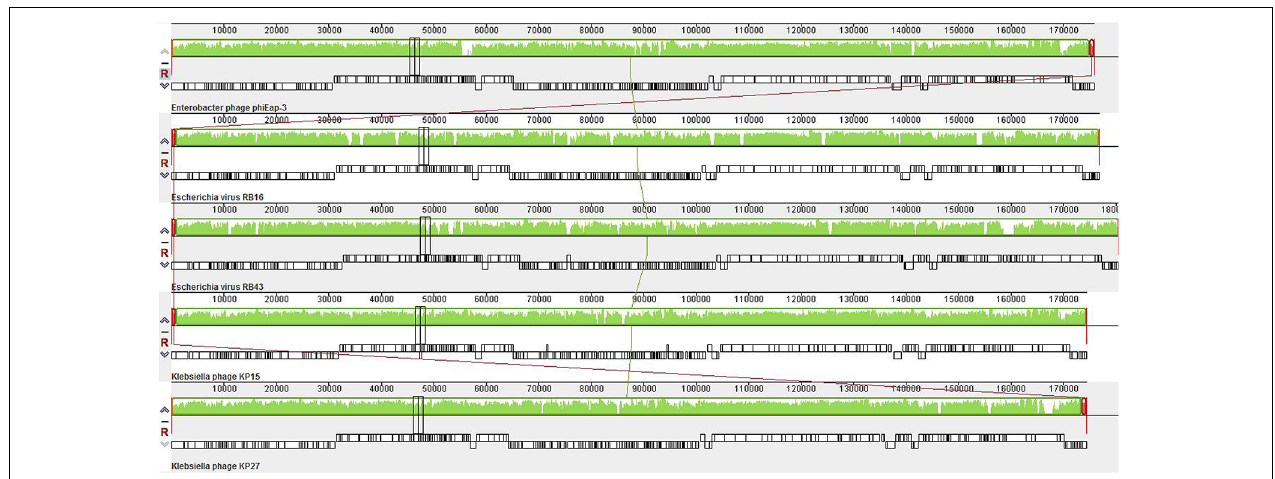
FIGURE 6 | Multiple alignment of the chromosomes of phage vB_EaeM_ ϕ Eap-3, coliphages RB16 and RB43, Klebsiella phages KP15 and KP27 obtained using Mauve software http://asap.ahabs.wisc.edu/mauve/. The height of the similarity profile corresponds to the average level of conservation in that region of the genome sequence. Completely white regions represent fragments that are not aligned or contain a particular genome-specific sequence